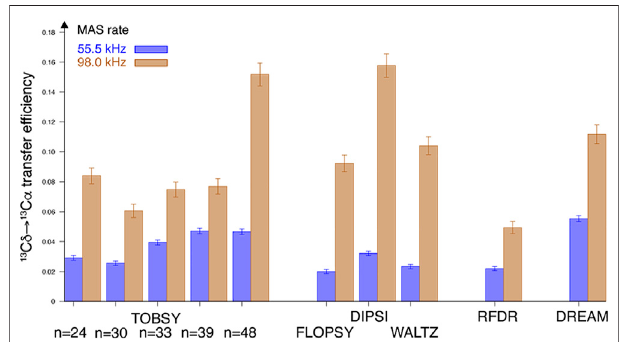
FIGURE 6 | Maximum absolute ef fi ciency of C δ 1 → C α magnetization transfer observed in leucine residue of fMLF at B 0 = 18.8 T fi eld and at ν R = 55.5 ( blue bars, left in each pair) and 98 kHz ( tan bars, right in each